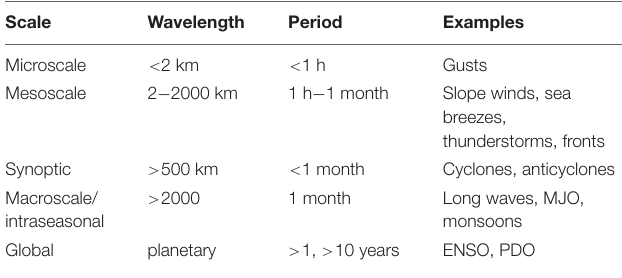
TABLE 1 | Some typical scales in meteorology and climatology (after Orlanski, 1975; Stull, 2017).